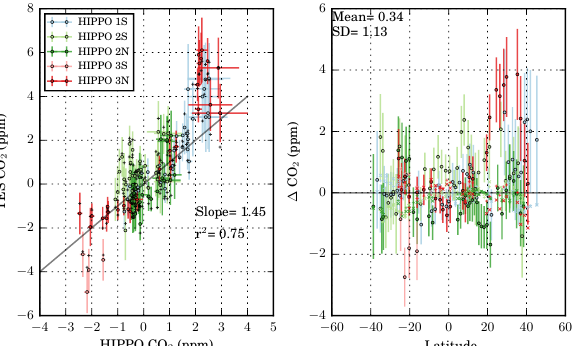
Figure 10. Left: scatter plot of normalized (with campaign average) CO 2 from individual HIPPO profiles ( x axis) against corresponding TES data. Right: difference plot of CO 2 against latitude. Campaigns as well as north and southbound tracks are color coded, model– HIPPO differences are plotted as well. Please refer to Fig. 7 for a detailed legend.